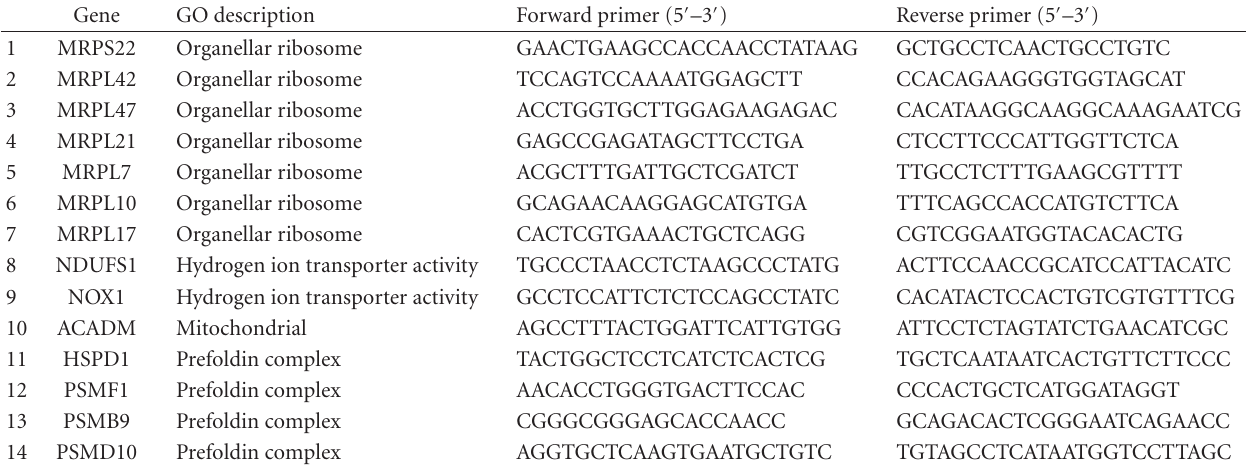
Table 2: The 14 selected genes for validation of gene expression and qPCR primer